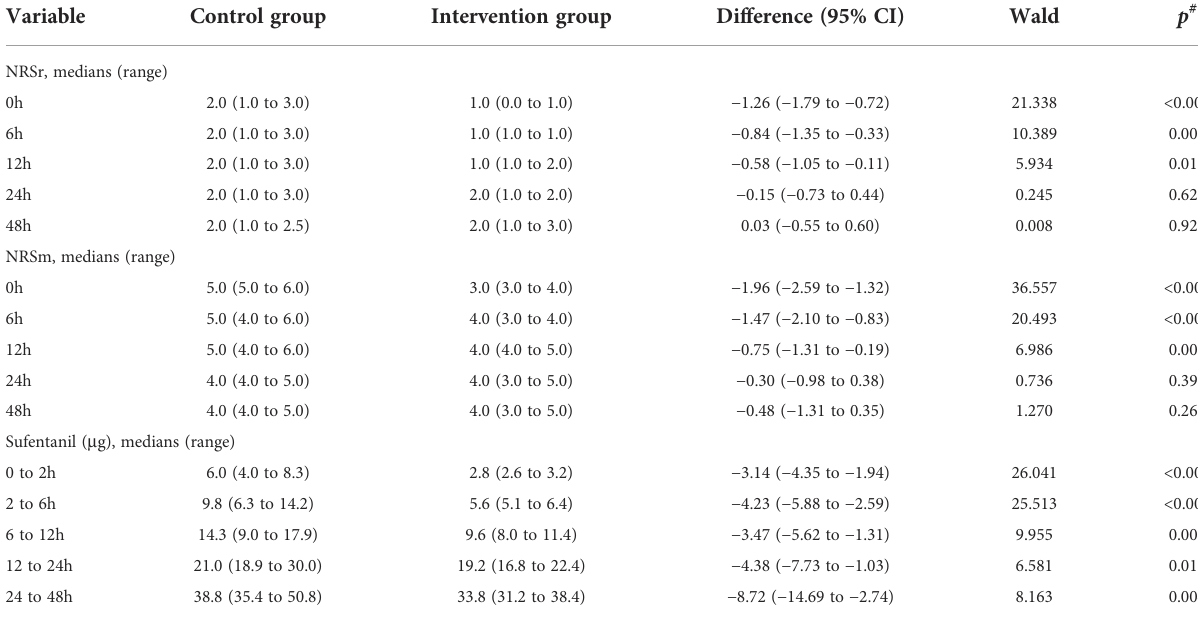
TABLE 2 The NRS scores at different time points and sufentanil consumption at different periods. Variable Control group Intervention group Difference (95%